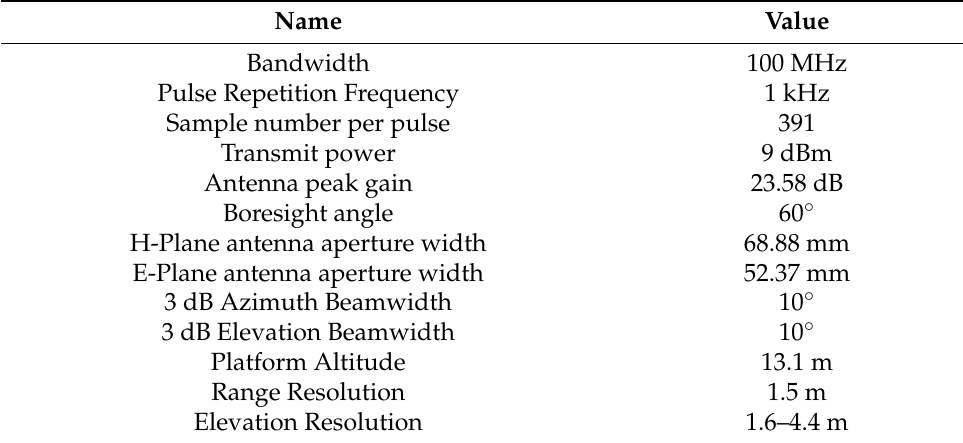
Table 1. KaBODS key system